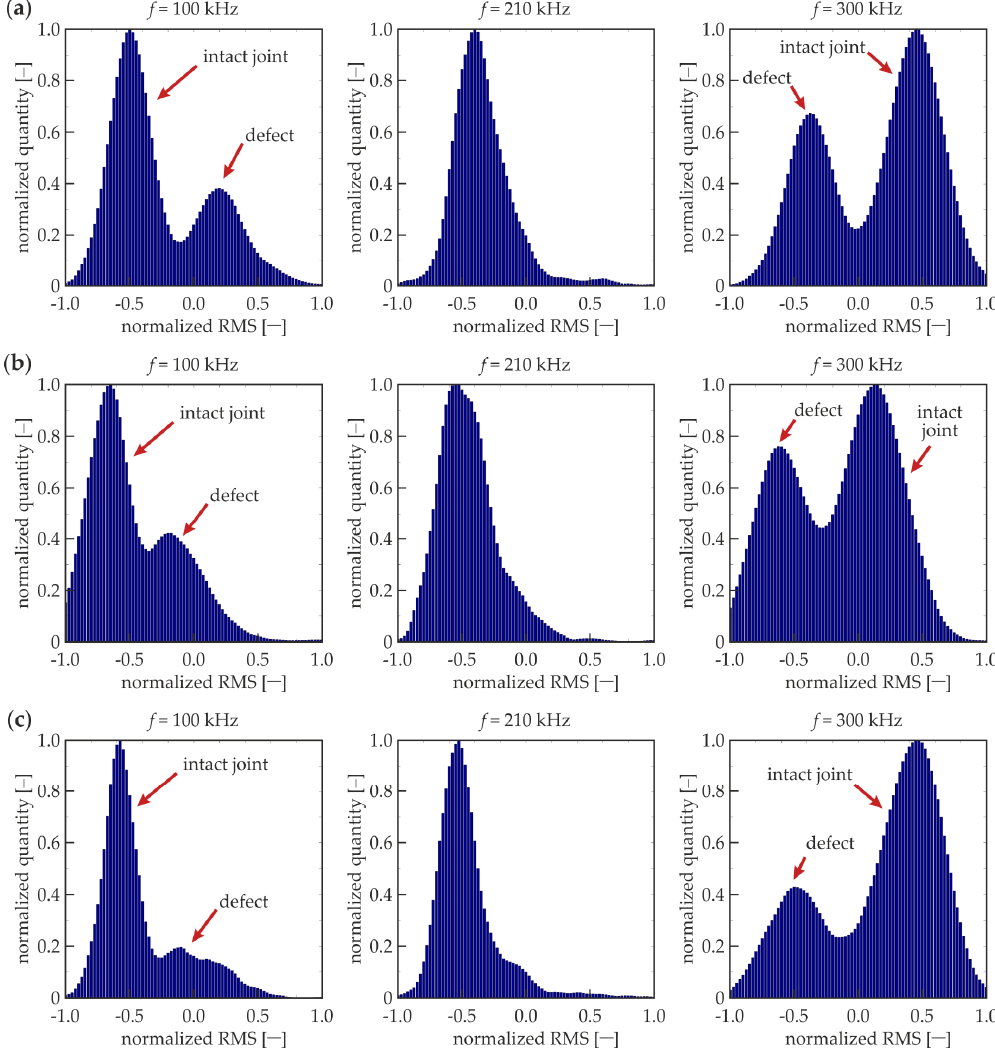
Figure 13. Numerical RMS histograms for different excitation frequencies (100, 210, and 300 kHz) and different defects: ( a ) #2; ( b ) #3; and ( c ) #4.